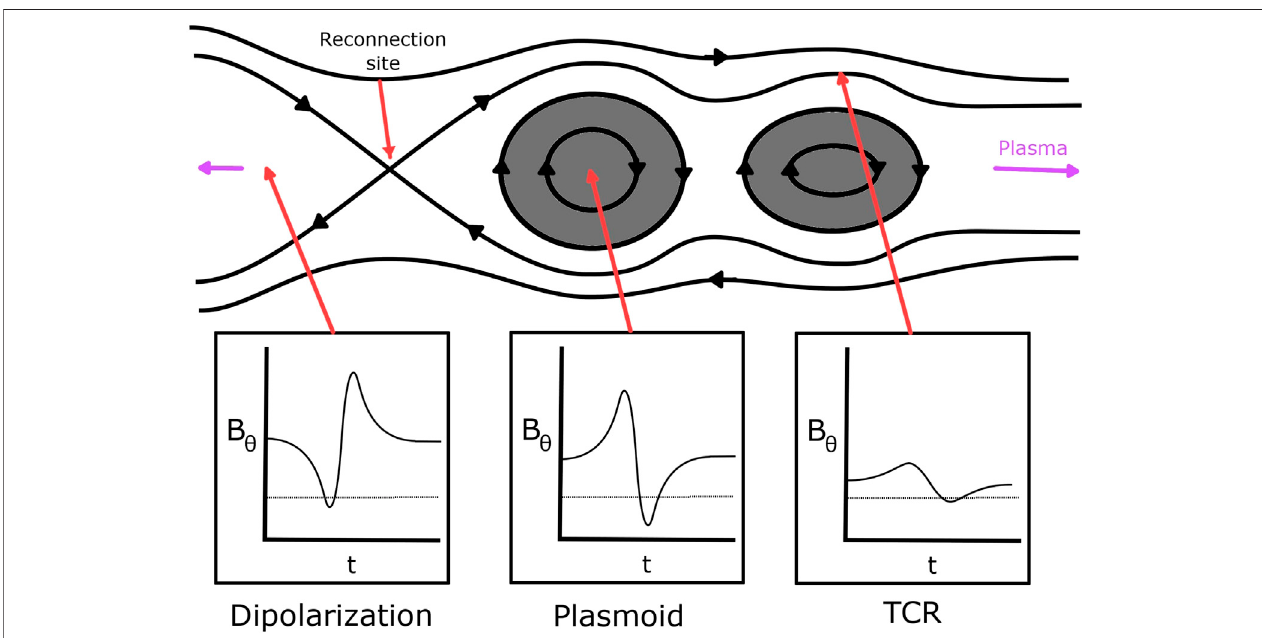
FIGURE 1 | Model north-south magnetic fi eld ( B θ ) measurements for a spacecraft as it passes through a dipolarization, plasmoid and TCR associated with a magnetic reconnection event. Notably, a signi fi cant de fl ection occurs as the spacecraft travels through the center of this region, with directionality of the fi eld even possibly being reversed (going from positive to